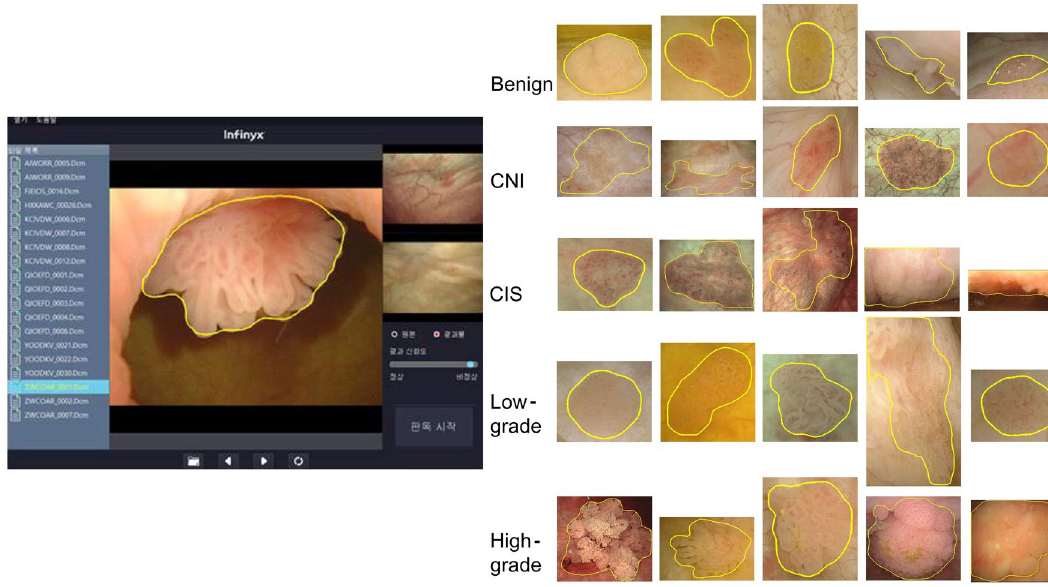
Figure 5. Visualization of bladder tumor contour recognized by AI. AI artificial intelligence, CIS carcinoma in situ, CNI chronic non-specific